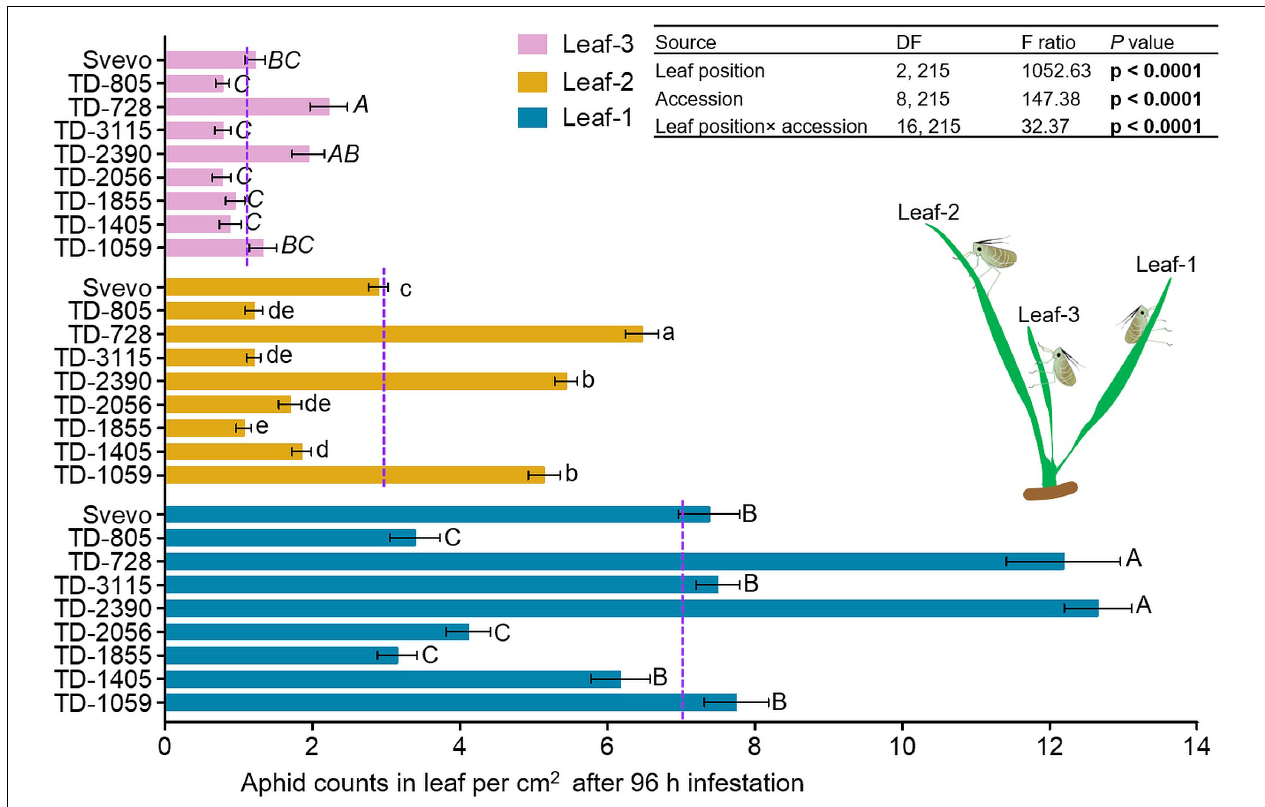
FIGURE 2 | Spatial performance of aphids on selected wheat genotypes. Aphid performance was evaluated in three leaf positions: leaf-1, leaf-2, and leaf-3. The number of total aphids per cm 2 in each leaf was shown at 96 h following infestation with Rhopalosiphum padi using the choice whole cage bioassay (mean ± SE, n = 8). The dashed purple lines represent the mean value of aphids per cm 2 on an individual leaf type among the accessions. The effects of leaf position, accession, and their interaction (leaf position × accession) were tested by two-way analysis of variance (ANOVA) analyses. In bold are the parameters that were significantly affected, p < 0.05. Significant differences between accessions are indicated by different letters (one-way ANOVA, Tukey’s honestly significant difference test, p <